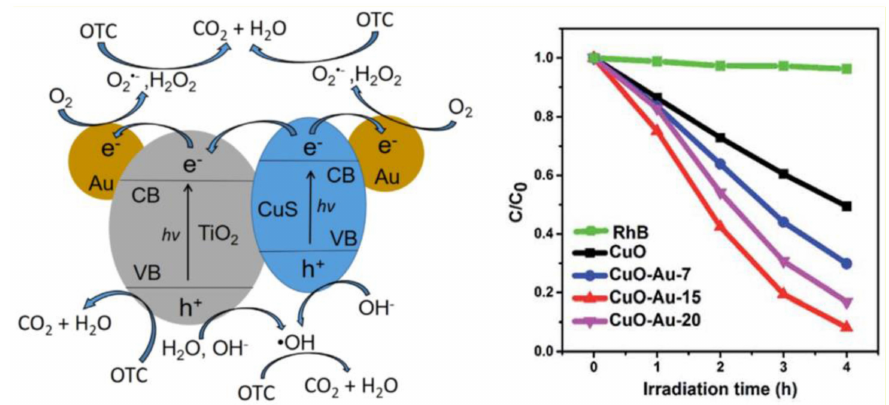
Figure 13. The role of CuS, TiO 2 and Au in ternary composites in the degradation of oxytetracycline(OTC) ( left ) (Reproduced with permission from Reference [161] published by American Chemical Society) and the photocatalytic performance of CuO-Au composites in the photodegradation of rhodamine-B ( right ) (Reproduced with permission from Reference [162] published by American Chemical